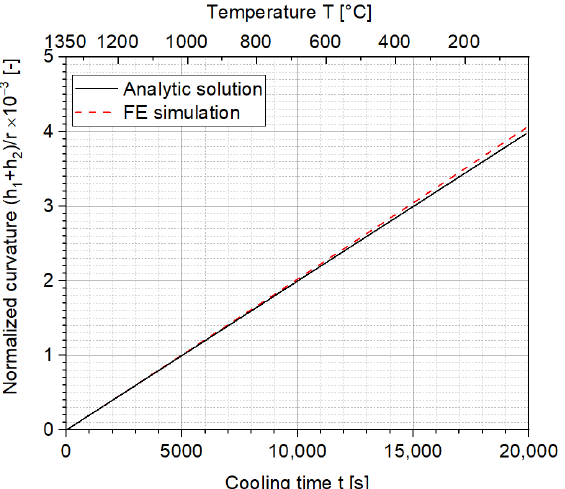
Figure 8. Comparison of the normalized curvatures between the analytic solution and FE simulation for the ideal scenario.